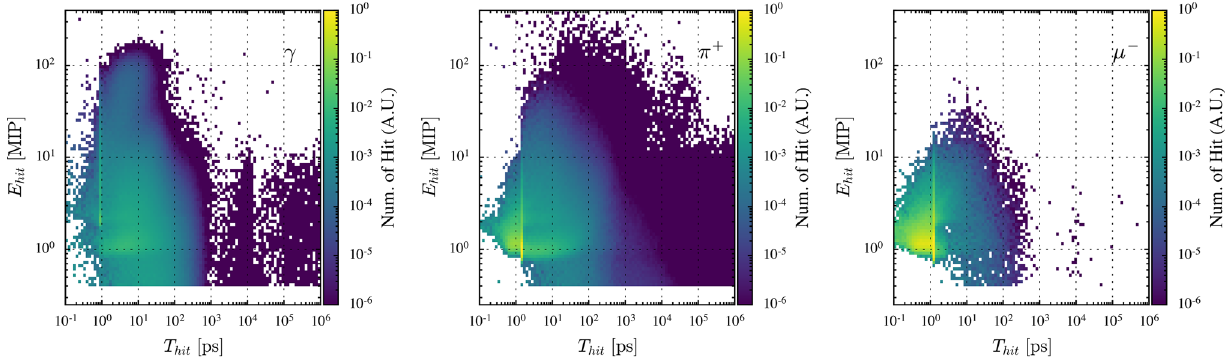
Fig. 5 The two-dimensional probability density distribution of the hits projected time and energy in 10 GeV γ (left), π + (middle) and μ − (right) samples. The total number of all the hits earlier than 1 µ s is normalized to unity